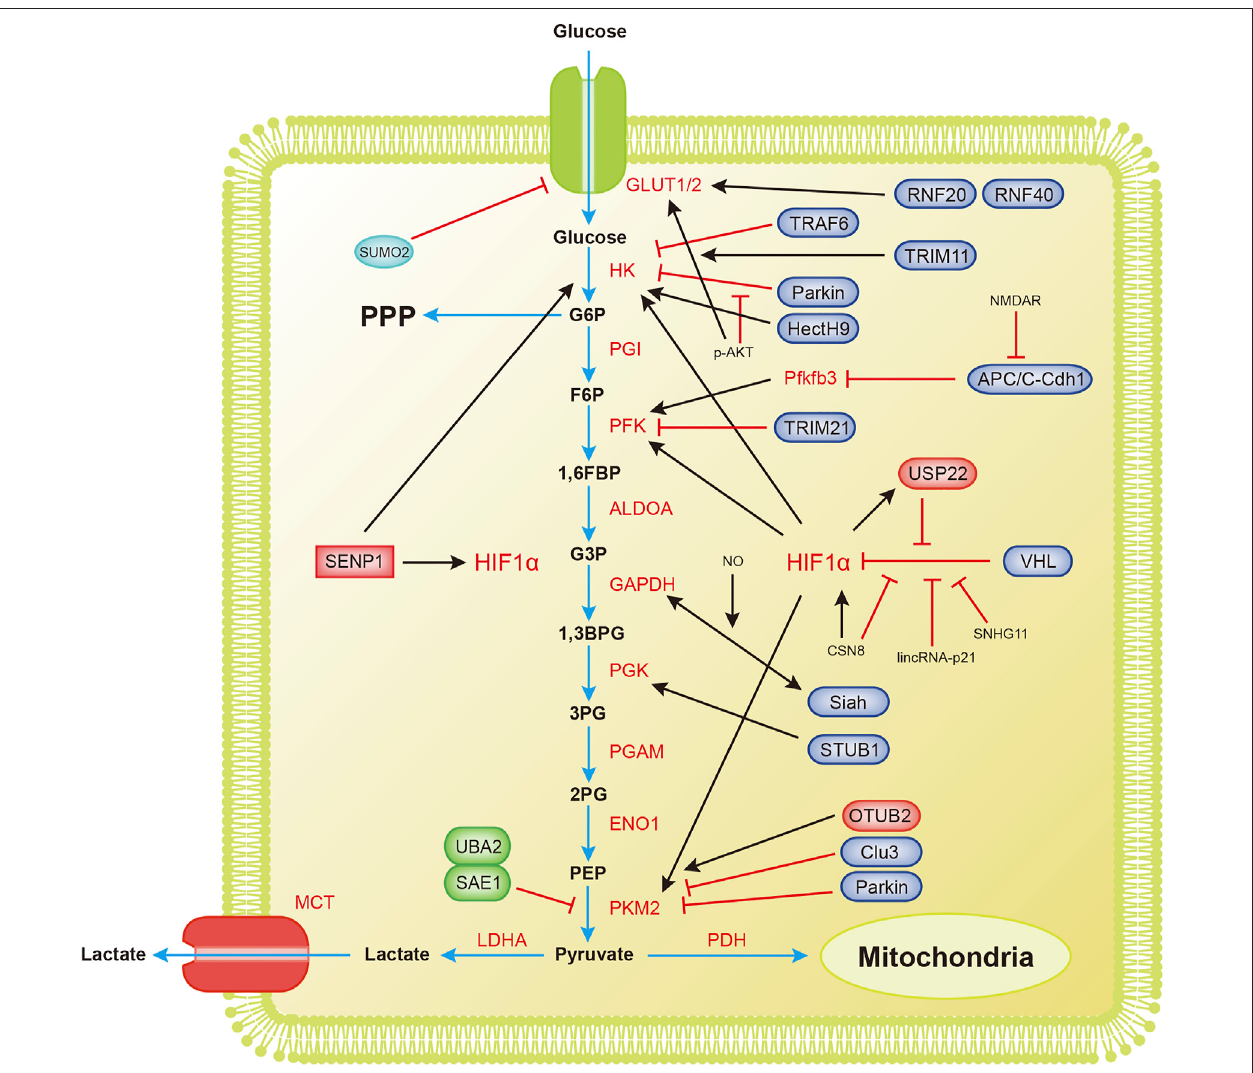
FIGURE2| OverviewofthemechanismsbywhichubiquitinationandSUMOylationregulateglycolysis.Thebluearrowrepresentsthe fl owofglycolyticsubstances. The black and red arrows represent activation and inhibition, respectively. 1,3BPG, 1,3-bisphosphoglycerate; 1,6FBP, fructose 1,6-biophosphate; 2PG, 3- phosphoglycerate; 3PG, 3-phosphoglycerate; ALDOA, aldose; APC/C-Cdh1, anaphase-promoting complex/cyclosome (APC/C)-Cdh1; ENO1, enolase; F6P, fructose 6-phosphate; G3P, glyceraldehyde 3-phosphate; G6P, glucose 6-phosphate; G6PDH, glucose-6-phosphate dehydrogenase; GAPDH, glyceraldehyde-3- phosphate dehydrogenase; GLUT1/2, glucose transporter 1/2; HIF1 α , hypoxia-inducible factor 1 α ; HK, hexokinase; LDHA, lactate dehydrogenase A; MCT, monocarboxylic acid transporter; OTUB2, OTU deubiquitinating enzyme; PDH, pyruvate dehydrogenase; PFK, phosphofructokinase; Pfkfb3, 6-phosphofructo-2- kinase/fructose-2,6-bisphosphatase3; PGAM, phosphoglucomutase; PGI, glucose-6-phosphate isomerase; PGK, phosphoglycerate kinase; PKM2, pyruvate kinase M2-type; PPP, pentose phosphate pathway; RNF20/40, ring fi nger protein 20/40; SAE1, SUMO-activating enzyme 1; SENP1, sentrin/SUMO-speci fi c proteases 1; STUB1, U-box containing protein 1; TPI, triode phosphate isomerase; TRAF6, TNF receptor-associated factor 6; TRIM11, tripartite motif (TRIM)-containing protein 11; TRIM21, tripartite motif (TRIM)-containing protein 21; UBA2, SUMO-activating enzyme 2; USP22, ubiquitin-speci fi c protease 22; VHL, von Hippel-Lindau protein.